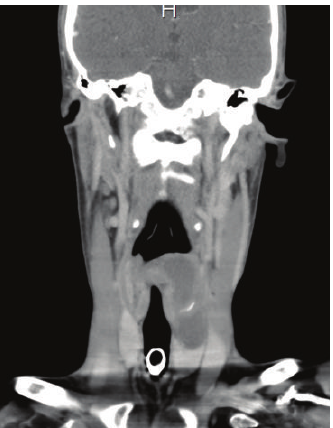
Figure 1: CT scan head and neck, coronal view, well circumscribed mass arising from the left supraglottic larynx extending into the left thyroid lobe.